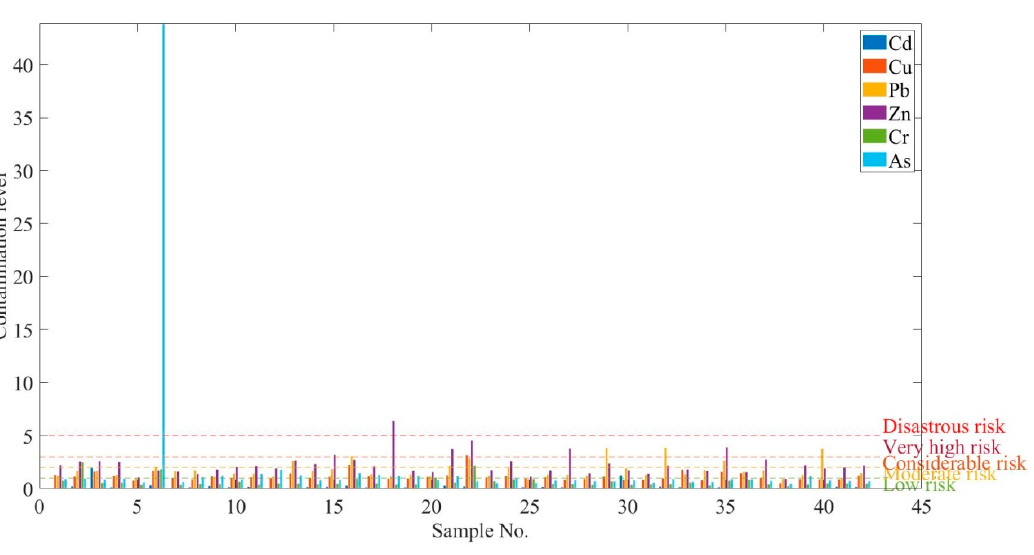
Figure 8. Contamination index of heavy metals.